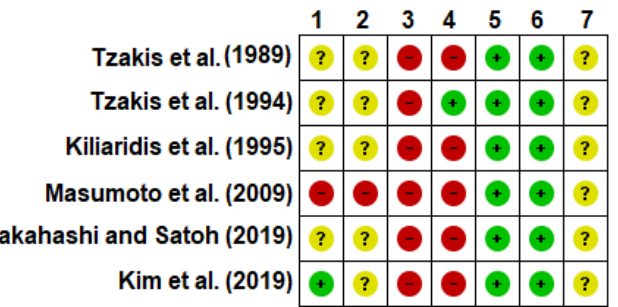
Figure 2. Risk of bias summary. 1. Random sequence generation (selection bias); 2. Allocation concealment (selection bias); 3. Blinding of participants and personnel (performance bias); 4. Blinding of outcome assessment (detection bias); 5. Incomplete outcome data (attrition bias); 6. Selective reporting (reporting bias); 7. Other bias. Note : The judgement for each entry involved assessing the risk of bias as ‘low risk’ (green), as ‘high risk’ (red), or as ‘unclear risk’ (yellow), with the last category indicating either lack of information or uncertainty over the potential for bias